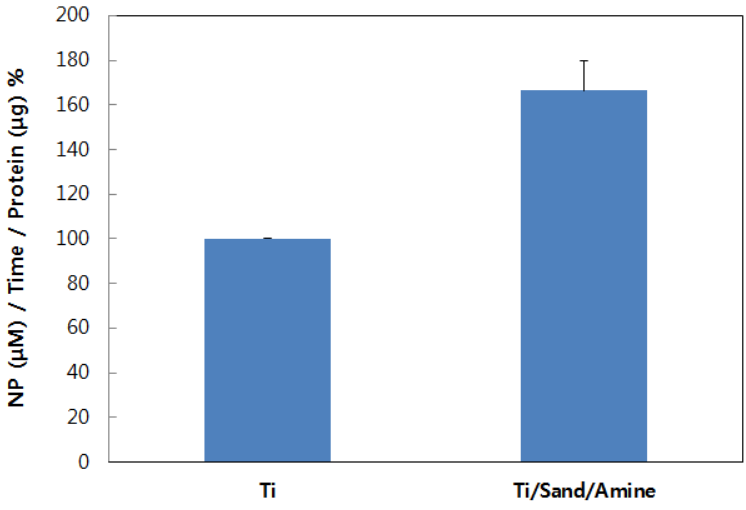
Figure 9. Alkaline phosphatase (ALP) activities of osteoblasts cultured for seven days on the untreated titanium surface and the titanium surface treated with amine plasma.